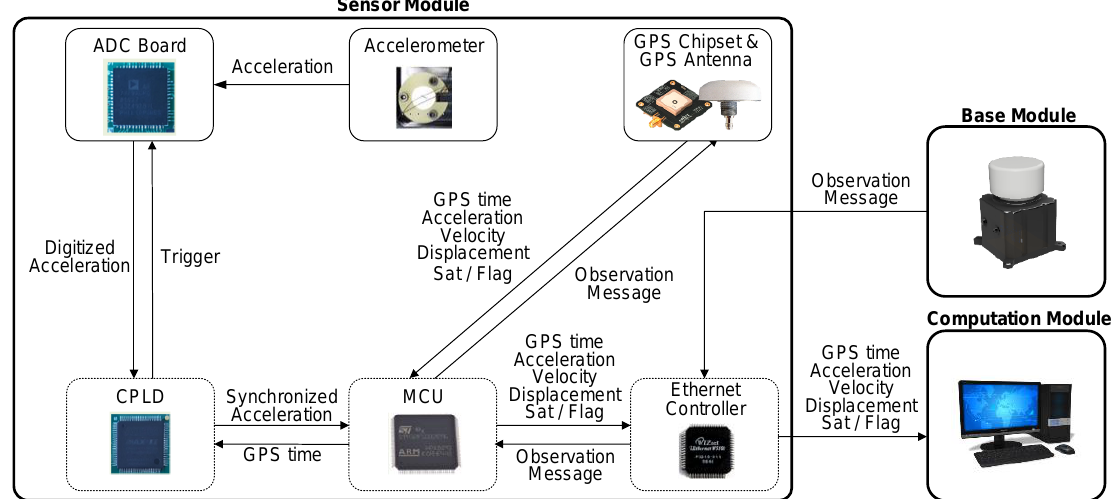
Figure 4. Block diagram of sensor module operation.